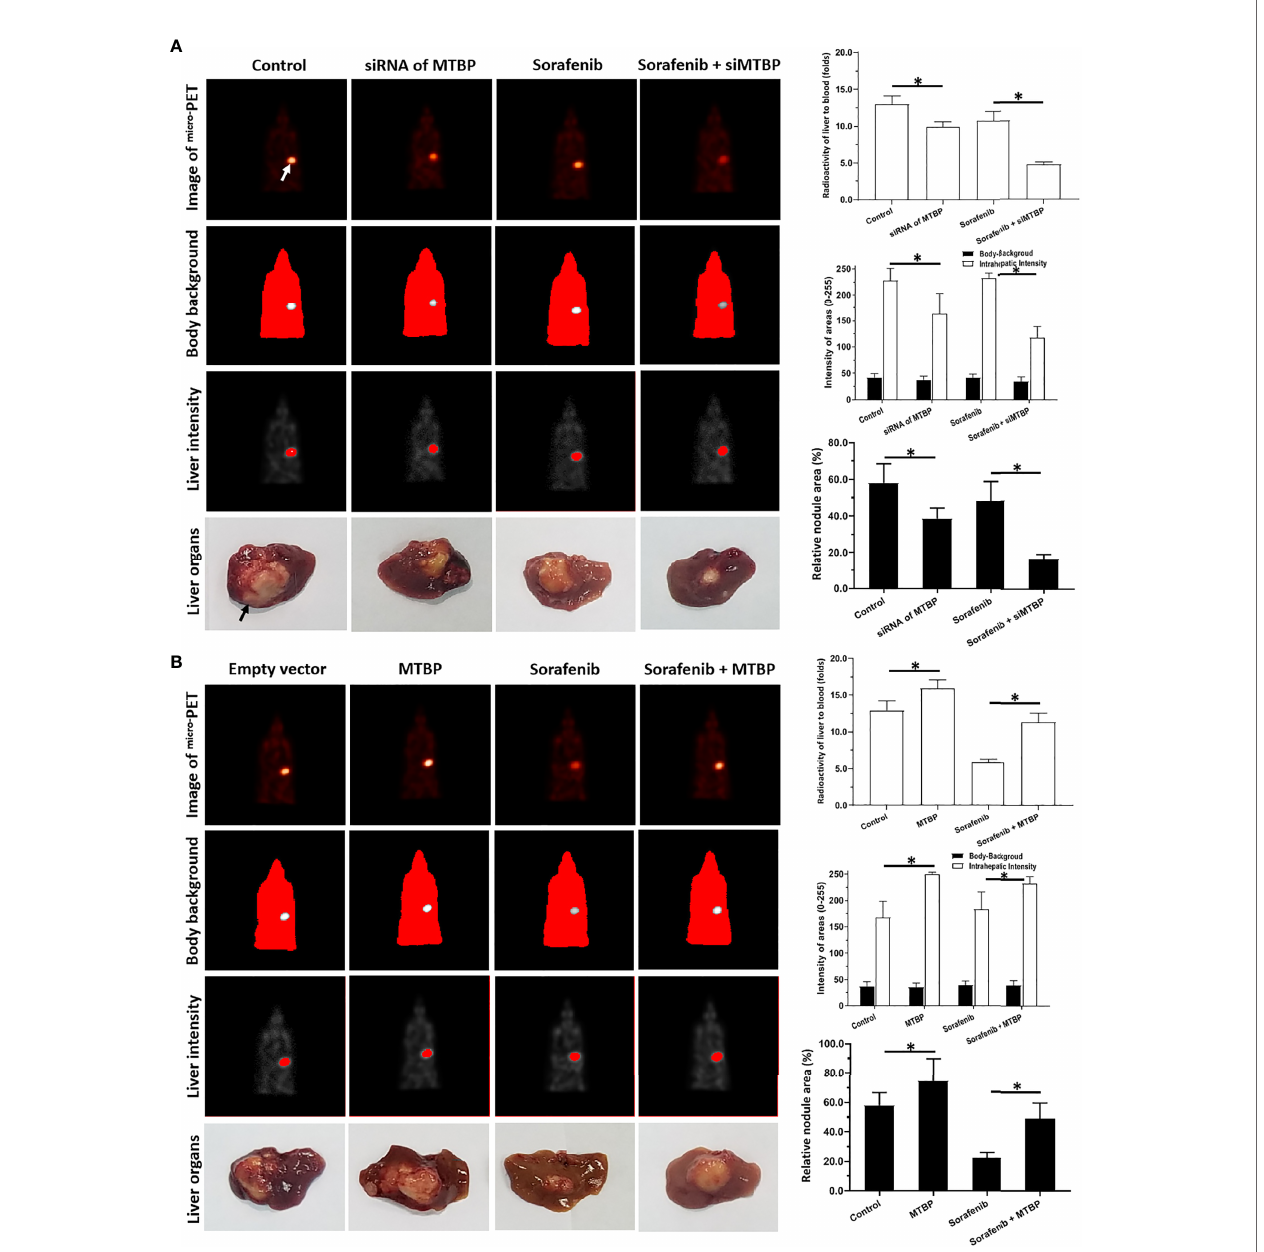
FIGURE 7 | MTBP decreased the antitumor effect of sorafenib on the subcutaneous growth HCC cells. (A) MHCC97-H cells were cultured and transfected with a control siRNA or the siRNA of MTBP. Cells were fi rst injected into mice to form subcutaneous tumor tissues; the micro-blocks of subcutaneous tissues were transplanted into the liver of each mouse to form intrahepatic tumor lesions (nodules). Then, the mice were given a sorafenib (0.5mg/kg) treatment via oral administration. The results were shown as the images of micro-PET, the quantitative results of micro-PET images (A) or the images of liver organs with nodules formed by HCC cells, the radio-activation of liver organs to blood, the intensity of liver regions to body-background (micro-PET ’ s images) or the relative area of the nodules. (B) MHCC97-L cells were cultured and transfected with empty vectors or the vectors of MTBP. Cells were fi rst injected into mice to form subcutaneous tumor tissues and the micro-blocks of subcutaneous tissues were transplanted into the each liver to form the intrahepatic tumor lesions (nodules). Then, the mice were given sorafenib (3.0mg/kg) treatment via oral administration. The results were shown as the images of micro-PET, the quantitative results of micro-PET images (A) or the images of liver organs with nodules formed by HCC cells, the radio-activation of liver organs to blood, the intensity of liver regions to body-background (micro-PET ’ s images) or the relative area of nodules. *P < 0.05 The white arrow in Figure 7 indicated the liver region from mirco PET examination; whereas the black arrow in Figure 7 indicated the nodules or lesions formed by HCC cells in the liver